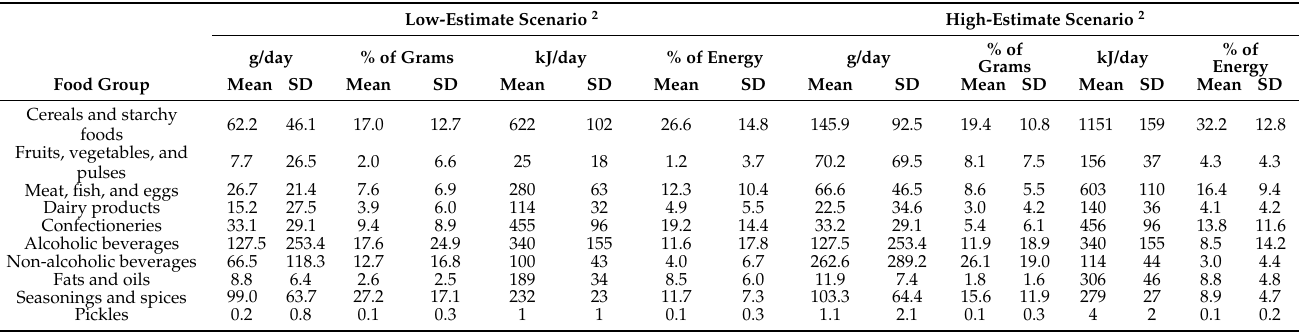
Table 2. Mean daily intake (g/day and kJ/day) of highly processed foods from each food group and their weight and energy contribution (%) 1 to the total intake of highly processed foods in 2742 Japanese